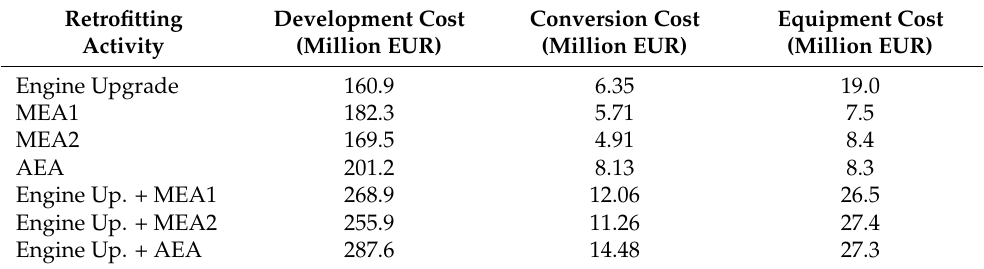
Table 11. Summary of total development, conversion and equipment costs required for every single aircraft to be upgraded, computed for seven different retrofitting activities.